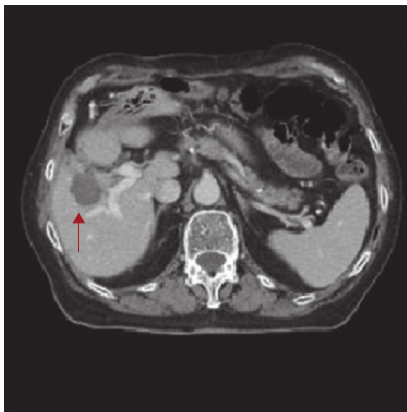
Figure 1: CT imaging of the liver lesion in segment V measuring 39 mm (arrow) that was treated with